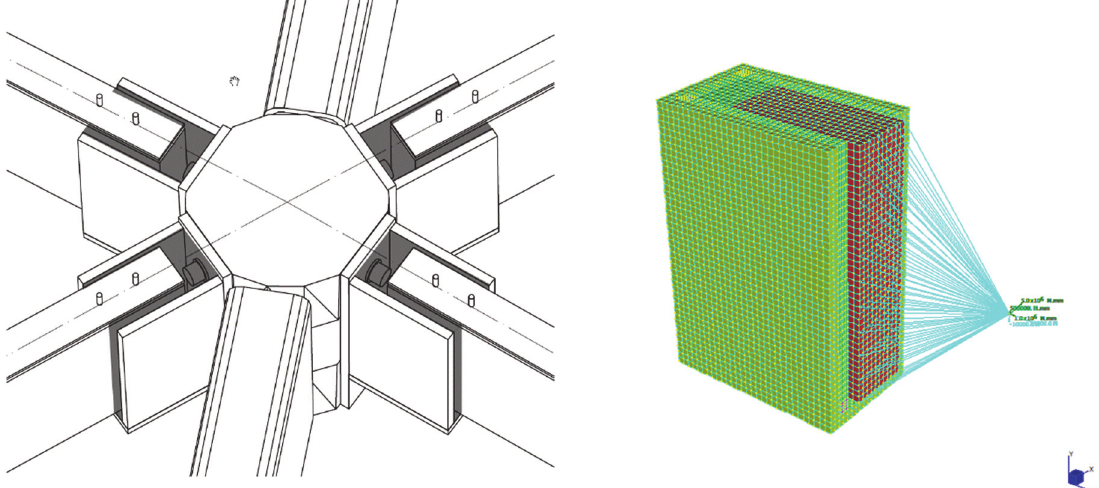
Fig. 9: Typical joint detail (left), Brick Model of the Silicone Connections